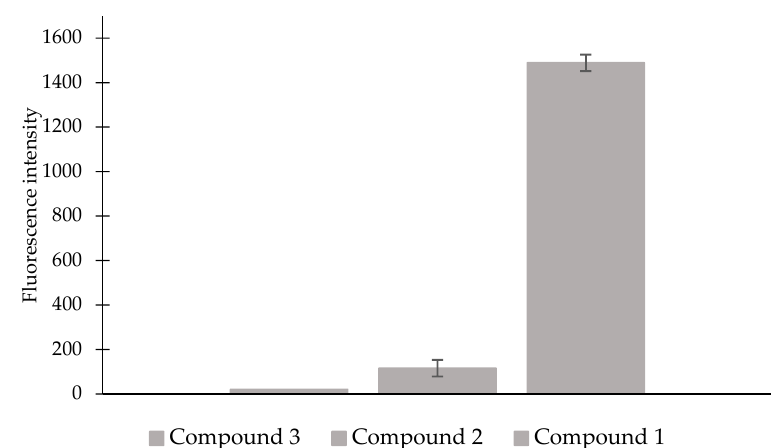
Figure 4. Comparison of fluorescence responses for the compound 1 , 2 and 3 (0.1 mM). Data were acquired at room temperature after addition of NaHS (0.1 mM) in sodium phosphate buffer (pH = 7.4, 20% CH 3 CN) with excitation at 365 nm. Means ± SE from three measurements of the fluorescence responses are presented.